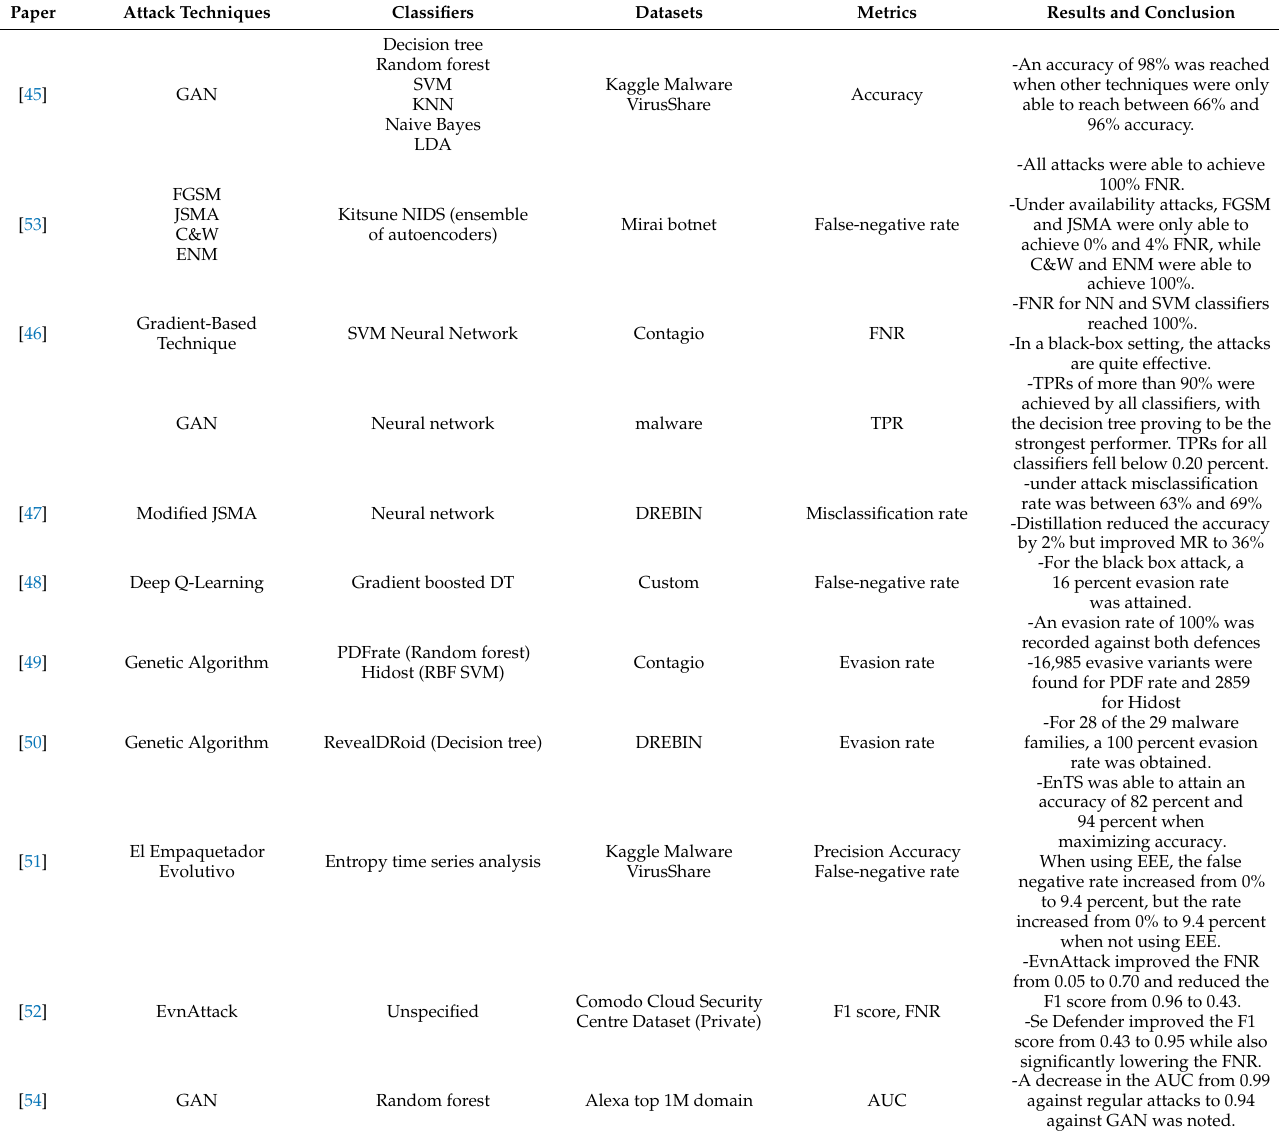
Table 3. Overview of existing adversarial attack